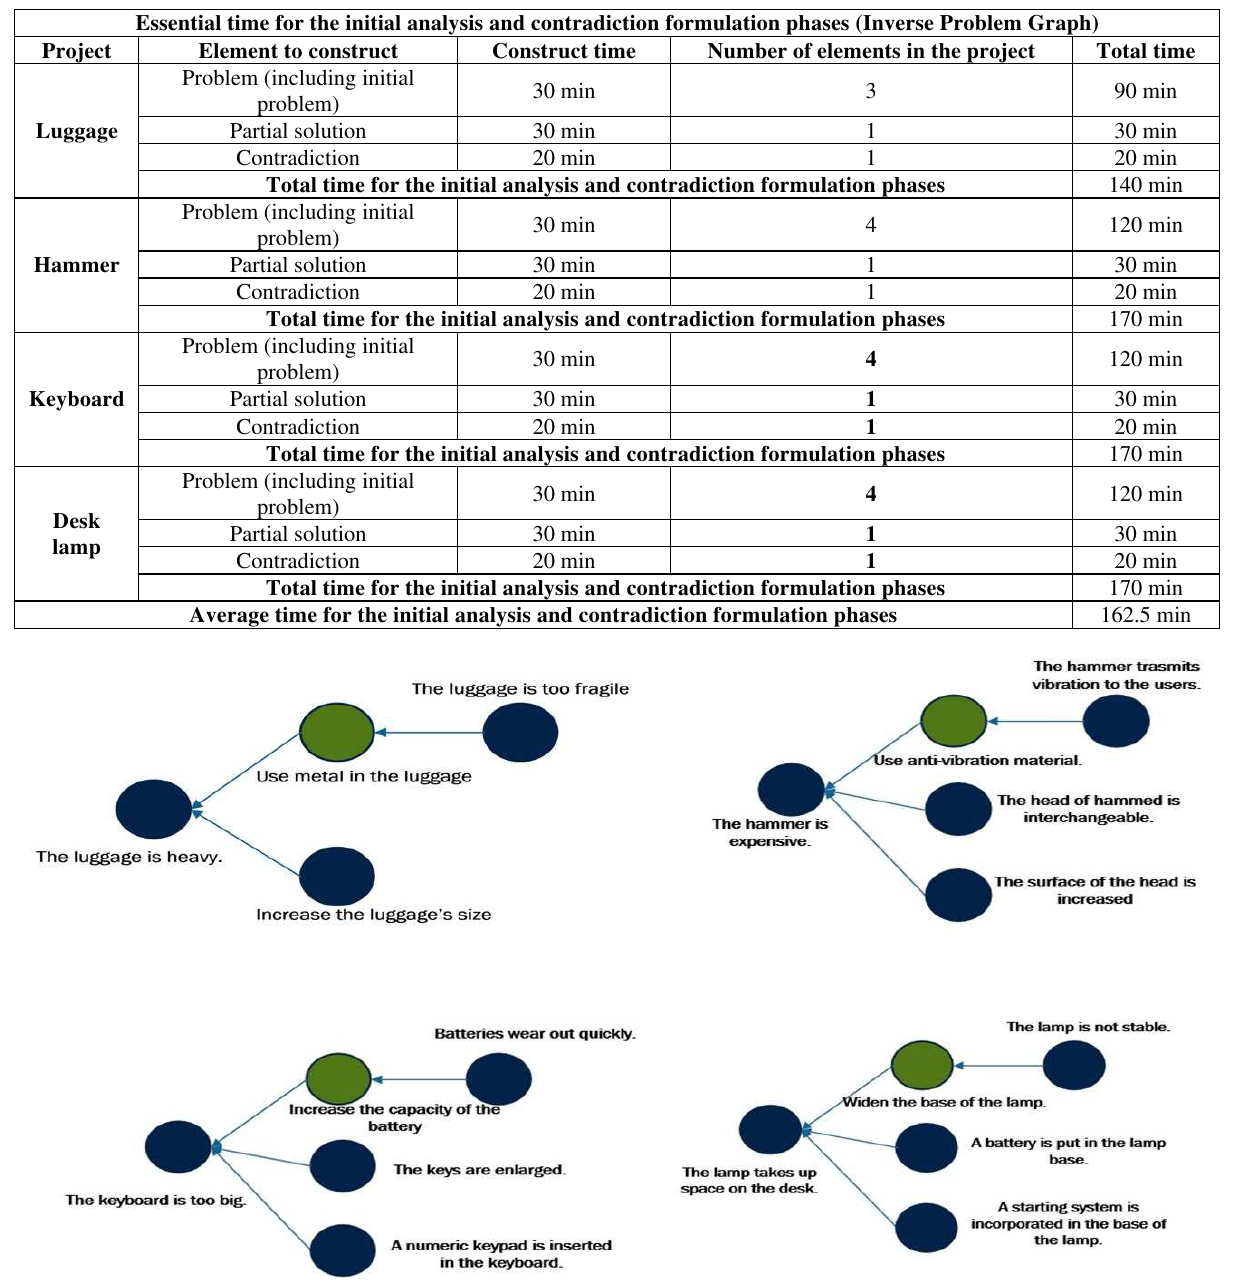
Figure 13. Application of the IPG method to the four student projects